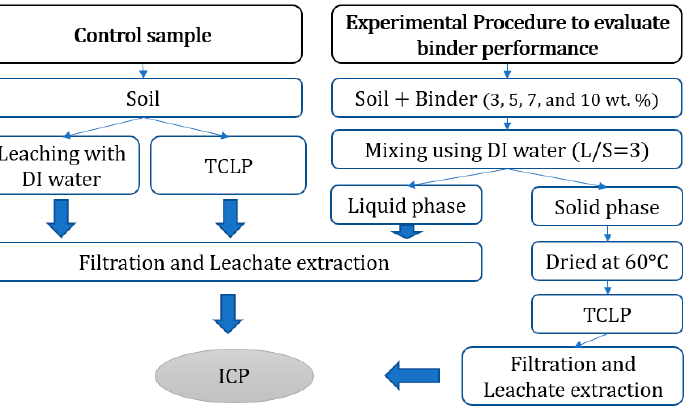
Figure 2. An overview of the experimental procedure for both the control sample (without binder) and soil after stabilized with the binder.